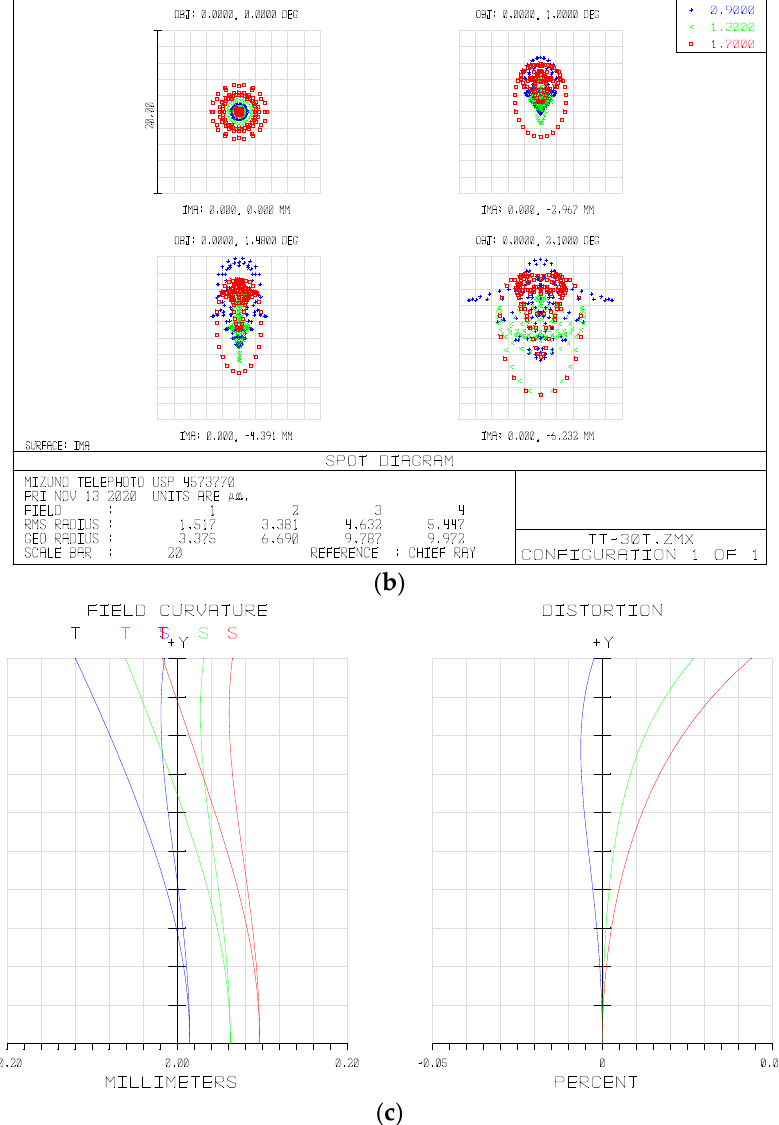
Figure 11. Optical performances of the overall system: ( a ) MTF of the system, ( b ) spot diagram, and ( c ) field curvatures and distortions of the different wavelengths.